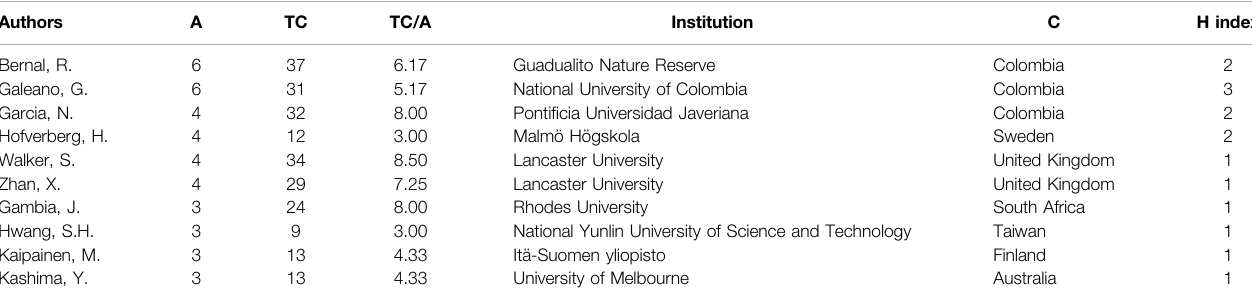
TABLE 3 | Most productive authors according to the number of research articles published. Source: Authors ’ own.